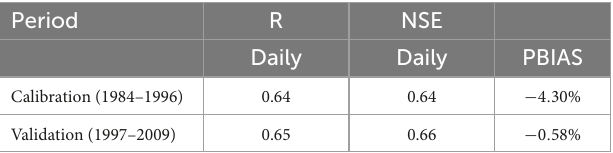
TABLE 5 Evaluation of the Jiujushui watershed’s SWAT model’s accuracy and reliability during calibration and validation.